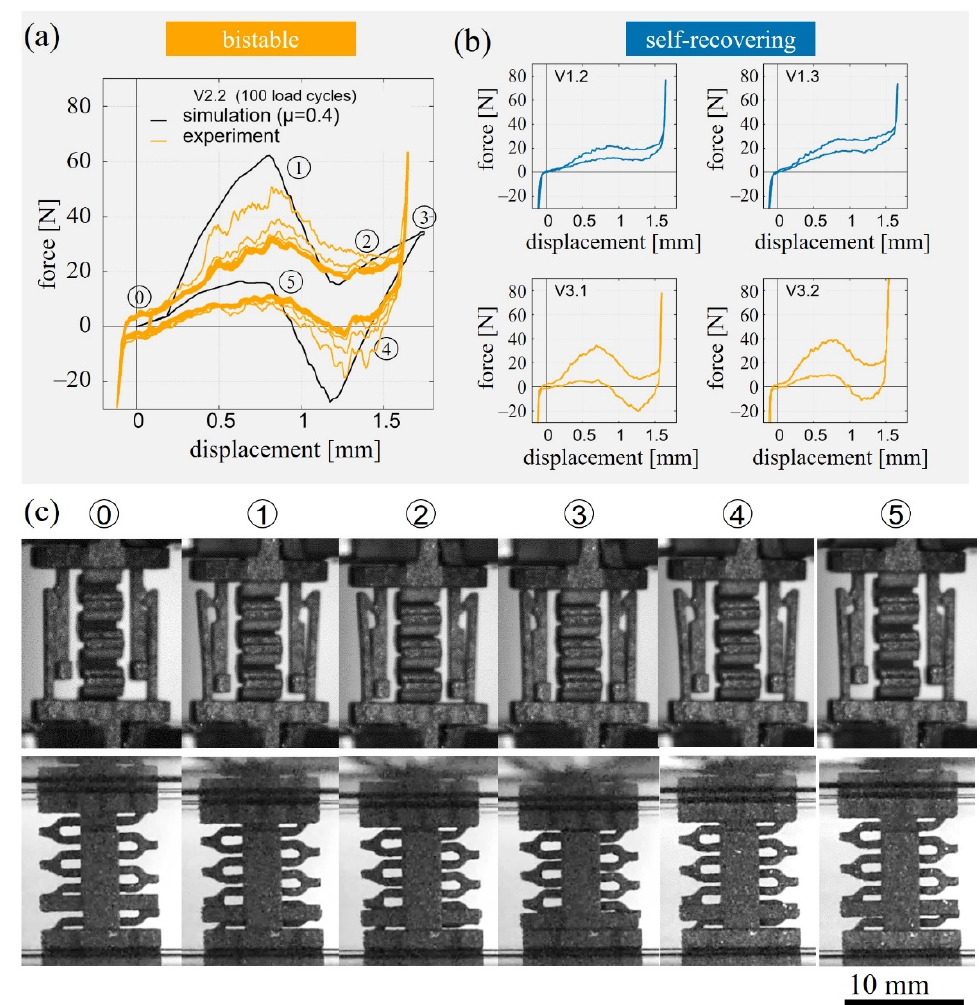
Figure 3. Force–displacement diagrams of frictional snap-fit cells V1.2, V1.3, V2.2, V3.1, V3.2 during cyclic compression and representative optical micrographs between the fully relaxed position (state 0) and fully compressed position (state 3); ( a ) experimentally obtained force–displacement curves during 100 load cycles for sample V2.2 (orange curve) and corresponding simulation results (black curve); ( b ) force–displacement curve of the 4th load cycle for the remaining geometries: V1.2, V1.3, V3.1, V3.2; ( c ) side views of the unit cell V2.2 in characteristic deformation states during cyclic com- pression.